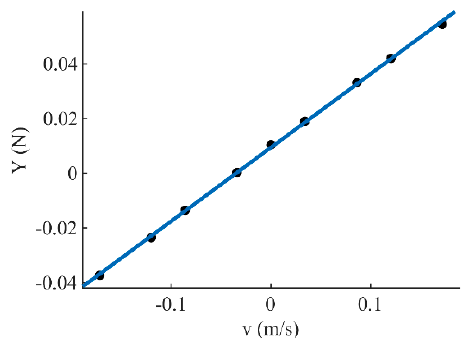
Figure 5. Fitted curve of vertical force Y and line velocity v.